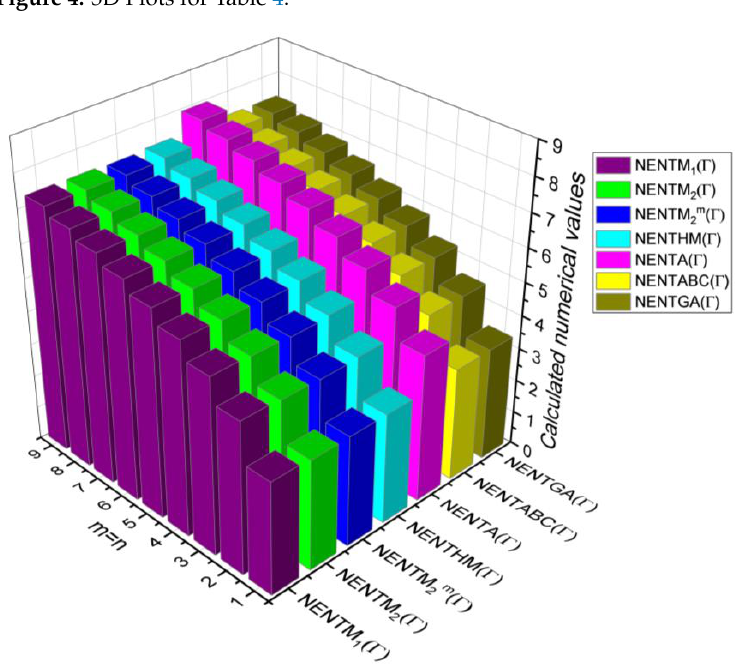
Figure 5. 3D Plots for Table 5.